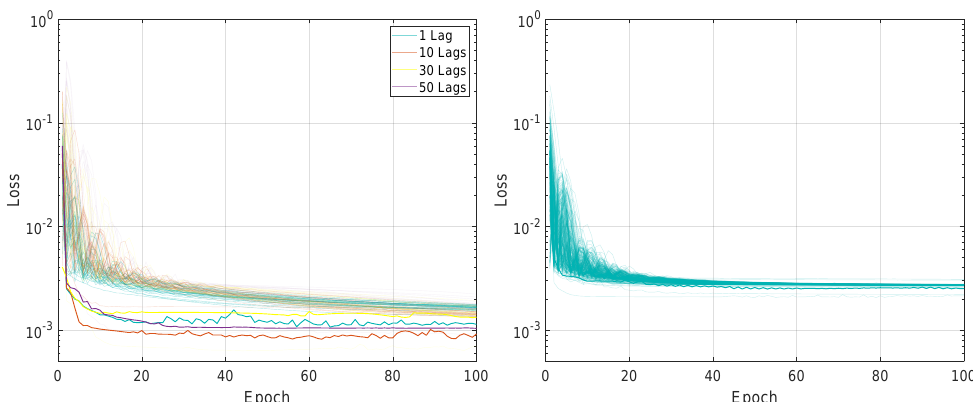
Figure 6. Illustration of the training loss for Experiment 2, LSTMTF ( left ) and VLSTM ( right ), using a many-to-many prediction mode. For each architecture, the lines with the same colors represent the loss for networks trained with mini-batch size in the [2:128] range. The highlighted thick lines represent the training loss for a mini-batch size of 2.